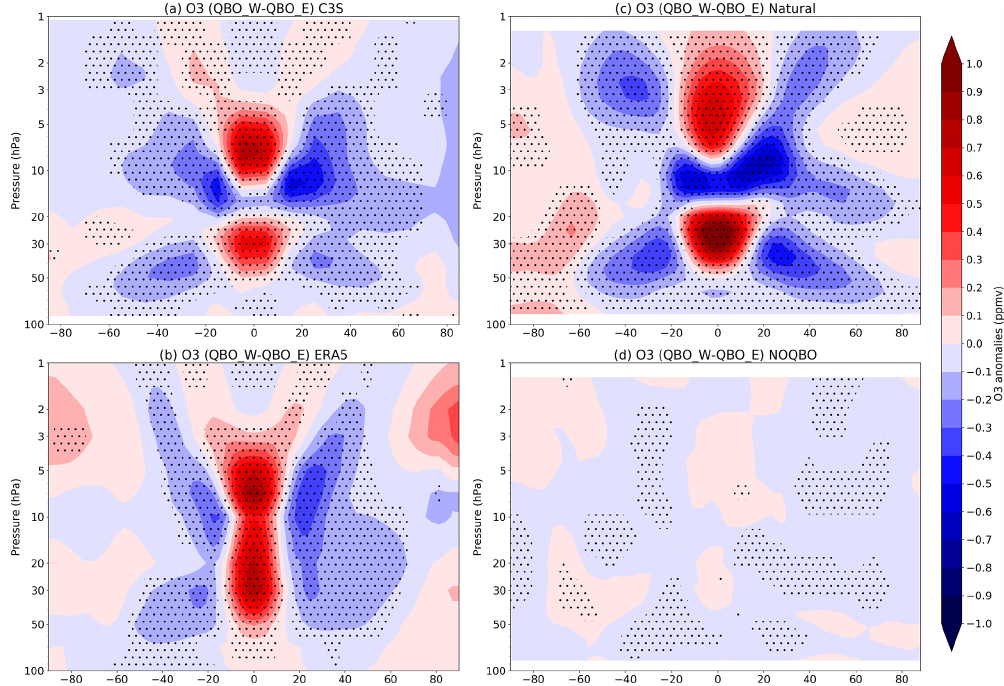
Figure 4. Latitude–height cross section of ozone anomalies associated with QBO (QBOW–QBOE), based on monthly anomalies of zonal mean ozone from different data sets for the period 1985–2020. (a) Merged satellite data from C3S. (b) ERA5 data. (c) CESM-WACCM natural run. (d) CESM-WACCM NOQBO run. Stippled areas indicate results that are statistically significant over the 99% level, using the two-tailed Student’s t